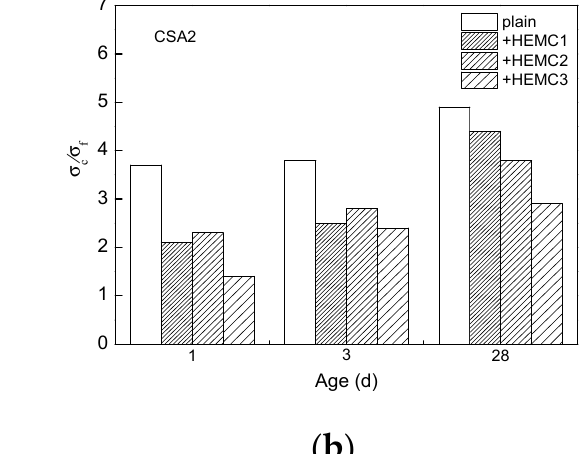
( b ) Figure 5. Tensile bond strength of CSA cement mortars with and without HEMCs at different curing ages: ( a ) CSA1, ( b ) CSA2. As for the tensile bond strength of CSA2 cement mortar, the effect of HEMC with different MS/DS on the tensile bond strength has changed, but the effect of PAAm has not